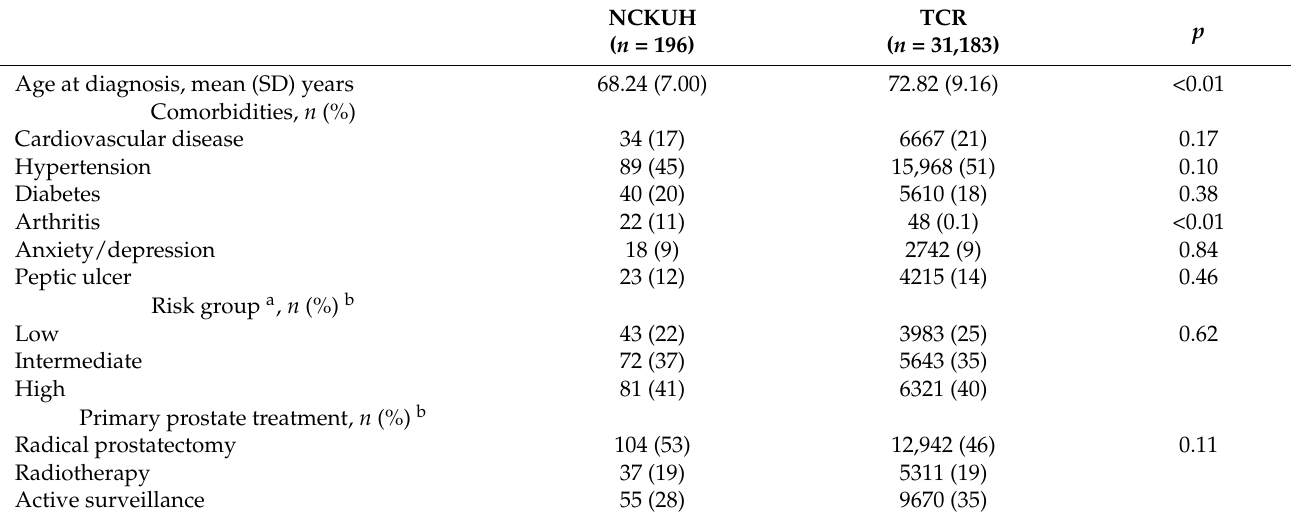
Table 2. Baseline clinical characteristics of participants at the National Cheng Kung University Hospital (NCKUH) and patients with localized prostate cancer registered in the Taiwan Cancer Registry